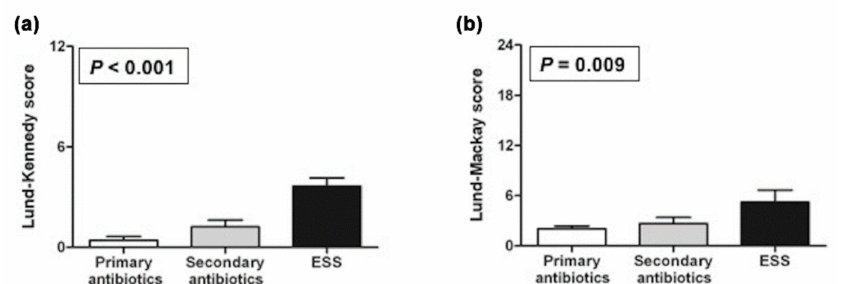
Figure 2. Lund–Kennedy scores of endoscopic assessment ( a ) and Lund–Mackay scores of computed tomography ( b ) in 53 patients with chronic rhinosinusitis before kidney transplantation. Both scores were significantly higher in patients treated with endoscopic sinus surgery (ESS) ( n = 10) than in those treated with primary ( n = 27) or secondary ( n = 16)